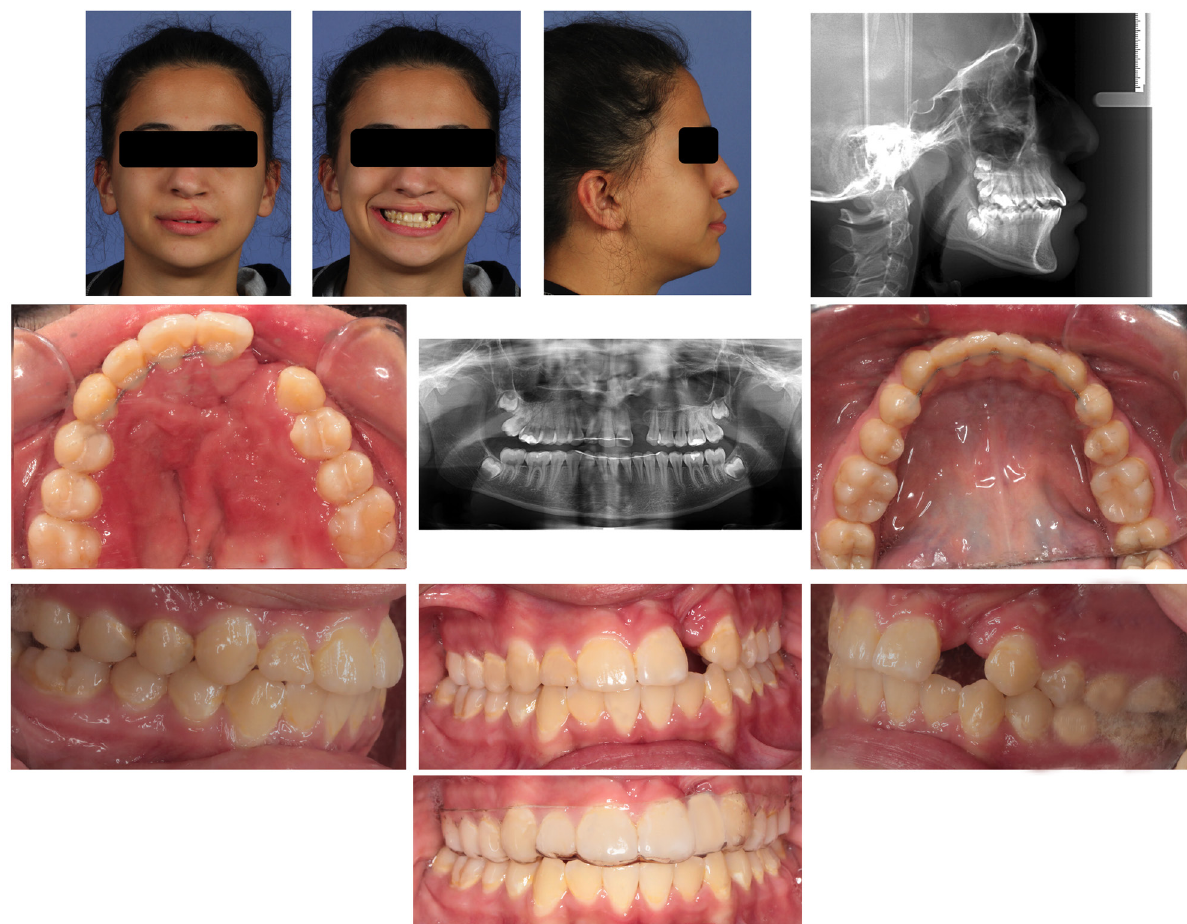
Figure 6. Post-treatment intraoral and extraoral profile and frontal photographs and panoramic and cephalometric radiographs. Modified essix retainer with acrylic artificial teeth applied for retention after orthodontic treatment.